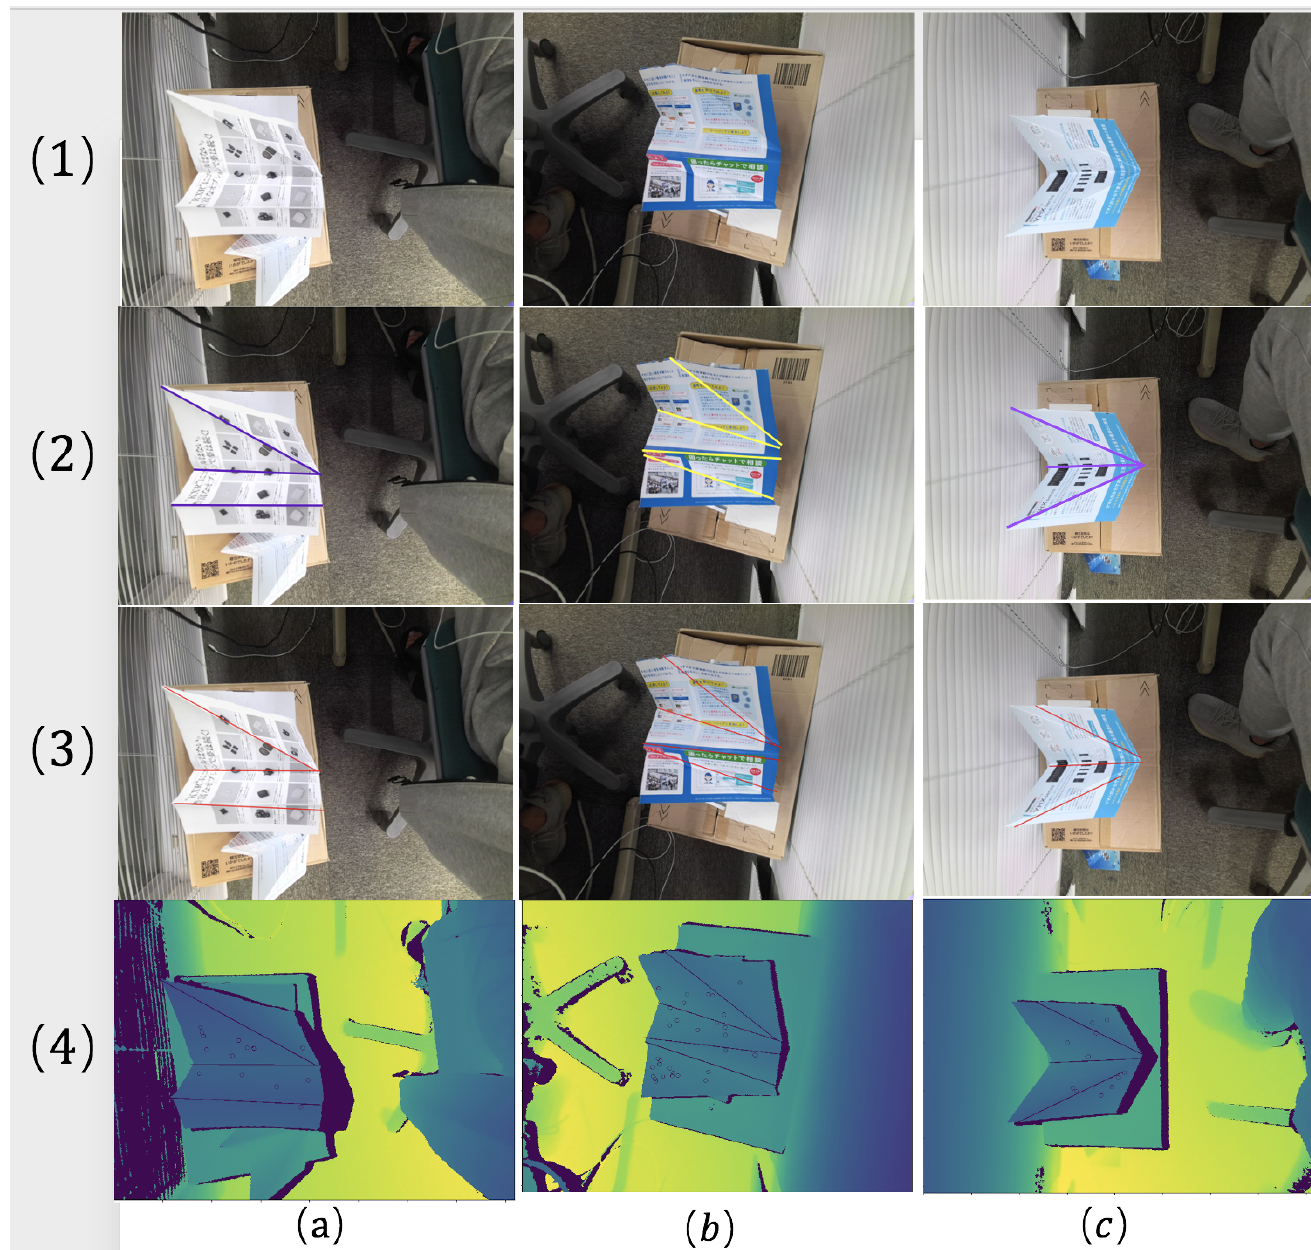
Figure 17. Three kinds of deformed paper ( a – c ): ( 1 ) RGB image; ( 2 ) ground truth of bending line; ( 3 ) projection of 3D bending line on the 2D RGB image; ( 4 ) projection of 3D bending line on the 2D depth